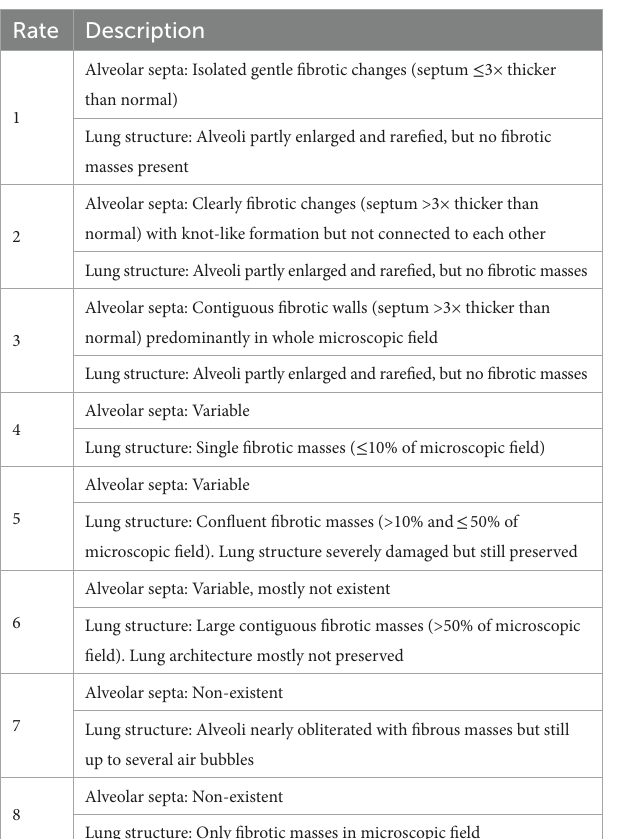
TABLE 1 Modified Ashcroft score(Hubner et al., 2008).